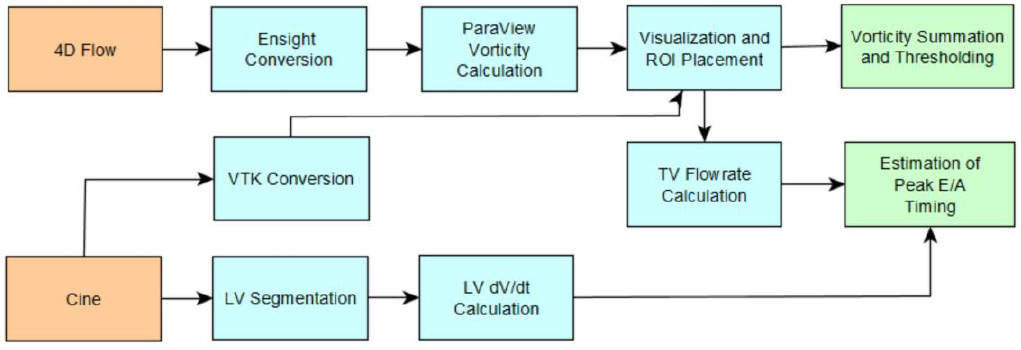
Figure 6. Process flowchart of postprocessing methodology using 4D Flow and Cine data to calculate spatially integrated vorticity and peak ealy (E) and late (A) wave timing.